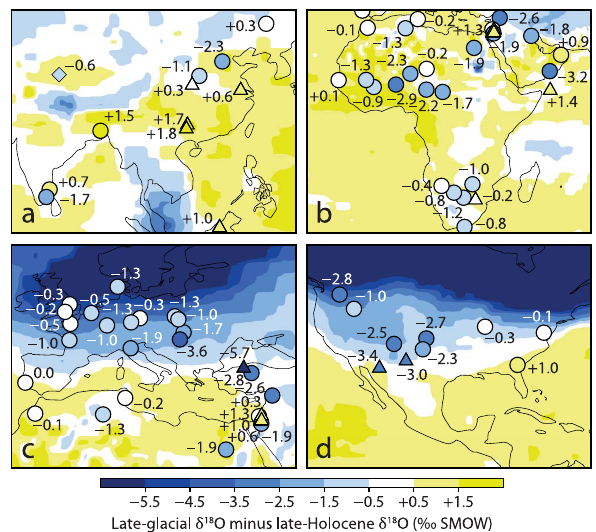
Figure 6. Regional proxy record (cid:49) 18 O late-glacial values for (a) southeastern Asia, (b) Africa, (c) Europe, and (d) the contiguous United States of America (where (cid:49) 18 O late-glacial = δ 18 O late-glacial − δ 18 O late-Holocene ). The multi-model ensemble median simulated (cid:49) 18 O late-glacial value is shown as a grid (0.5 de- gree smoothing). Groundwater records are represented by circles, speleothems by triangles, and ice cores by diamonds, labels show measured (cid:49) 18 O late-glacial values for each individual